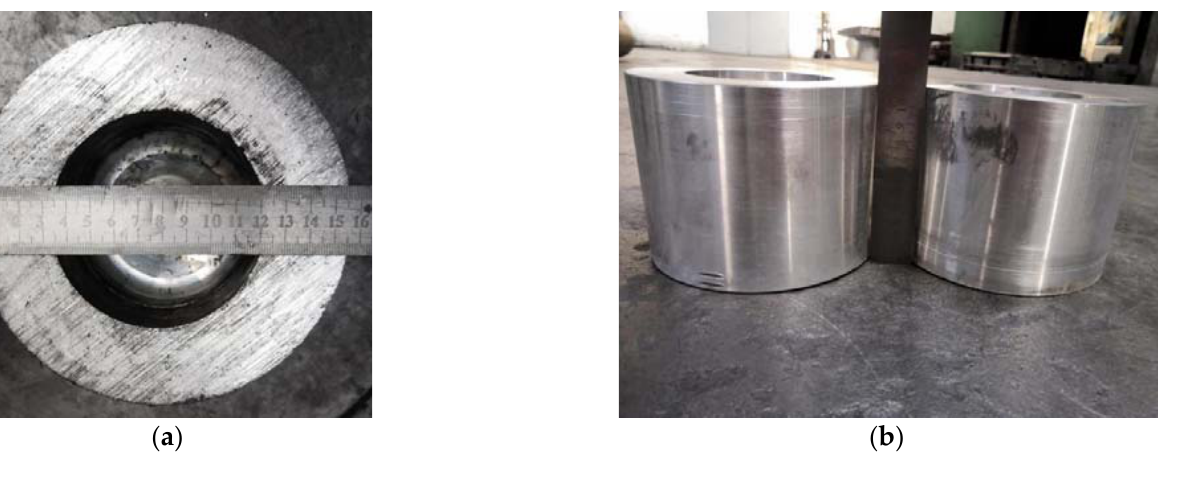
Figure 16. Billets for roll forming: ( a ) top view; ( b ) front view.